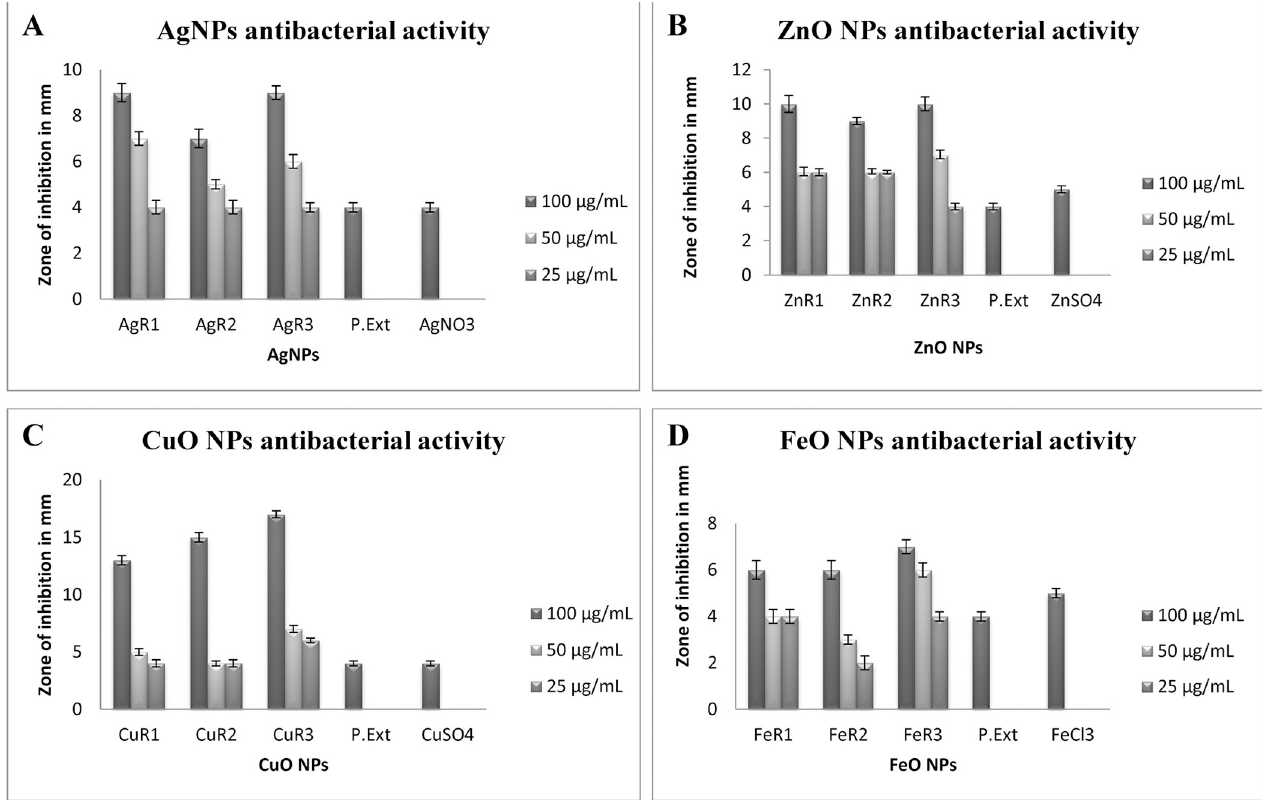
Fig 8. Antibacterial activity of (A) AgNPs synthesized by using 10 mL of 2 mM AgNO 3 solution with 10, 20 and, 30 mL of R . communis extract (B) ZnO NPs synthesized by using 10 mL of 2 mM ZnSO 4 solution with 10, 20 and, 30 mL of R . communis extract (C) CuO NPs synthesized by using 10 mL of 2 mM CuSO 4 solution with 10, 20 and, 30 mL of R . communis extract (D) FeO NPs synthesized by using 10 mL of 2 mM FeCl 3 solution with 10, 20 and, 30 mL of R . communis